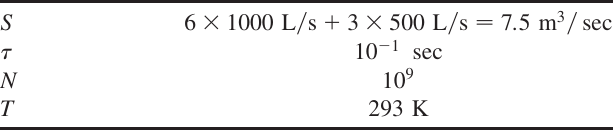
TABLE VI. Parameters of gas